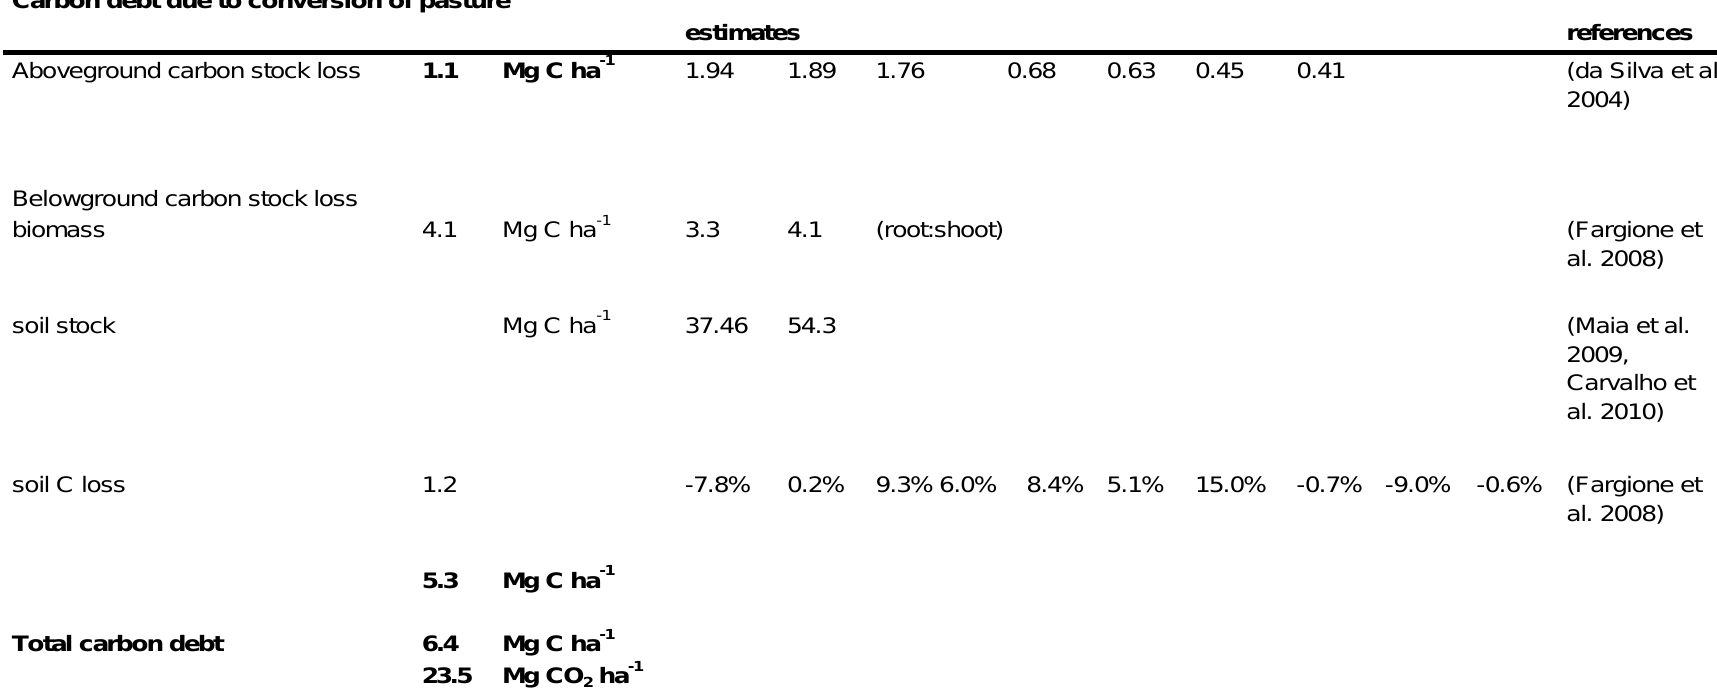
Table A6.2. Carbon debt calculation of Guarantã do Norte & Alta Floresta, Brazil case Carbon debt due to conversion of